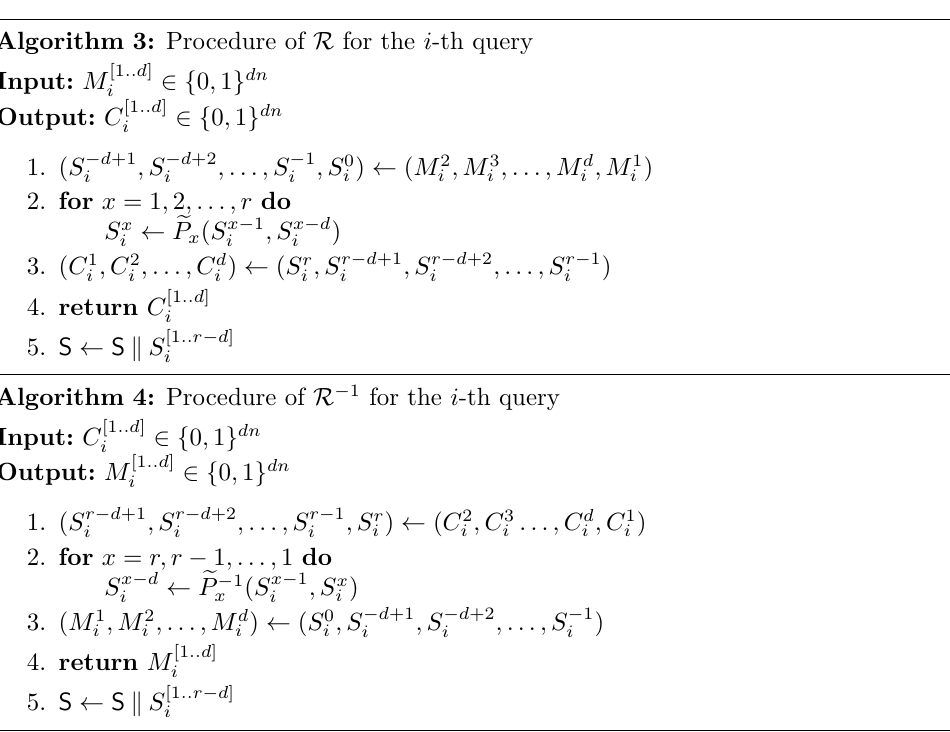
Figure 8: Definition of R and R − 1 for the SPRP proof of E 1 ,d,r . Initially, S is empty, and S is given to A after it makes all the q